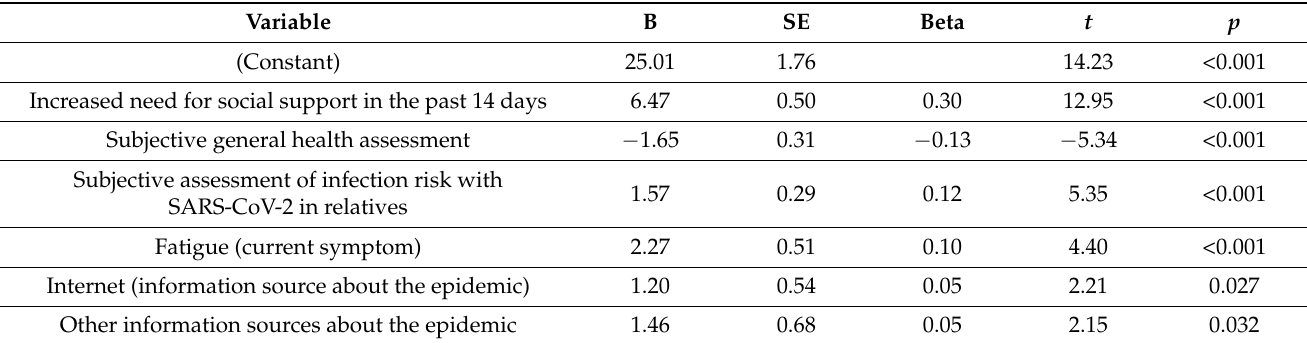
Table 6. Results of linear regression analysis for anger